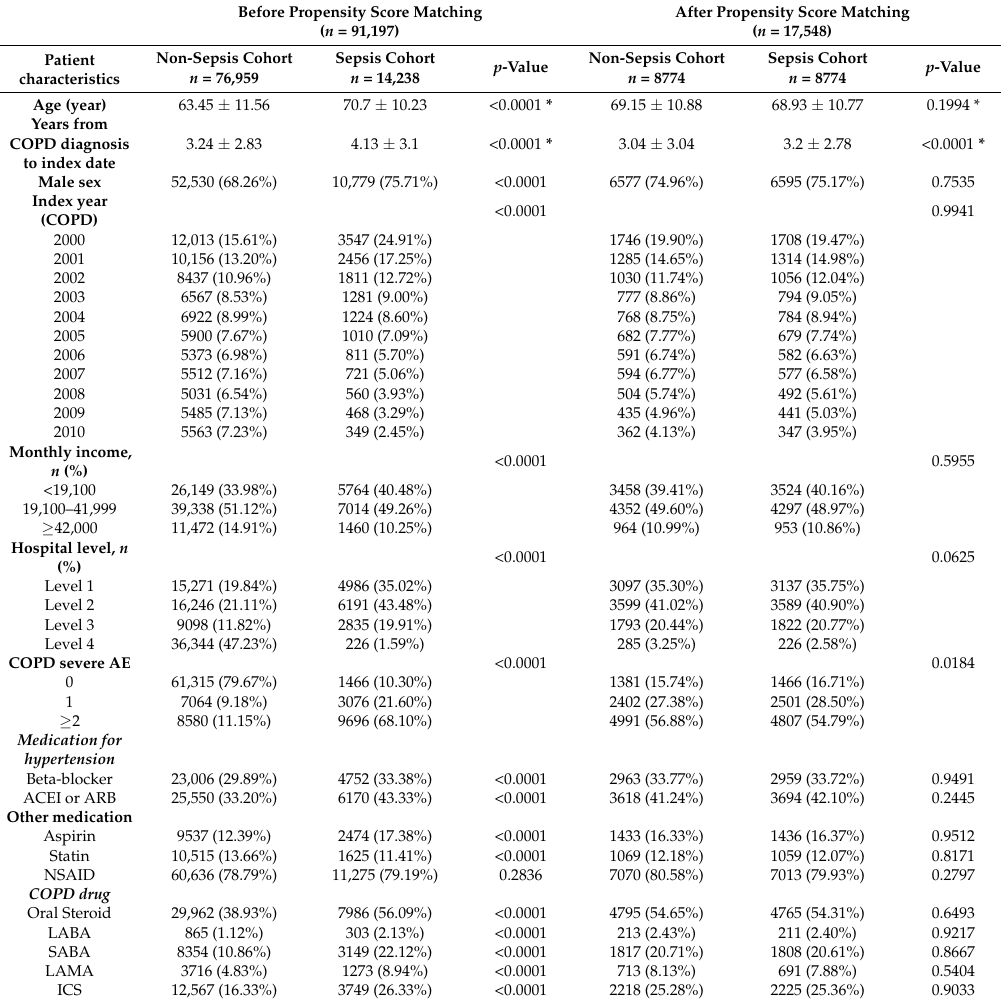
Table 1. Baseline characteristics of study population stratified by sepsis before and after propensity score matching. Before Propensity Score Matching ( n = 91,197)